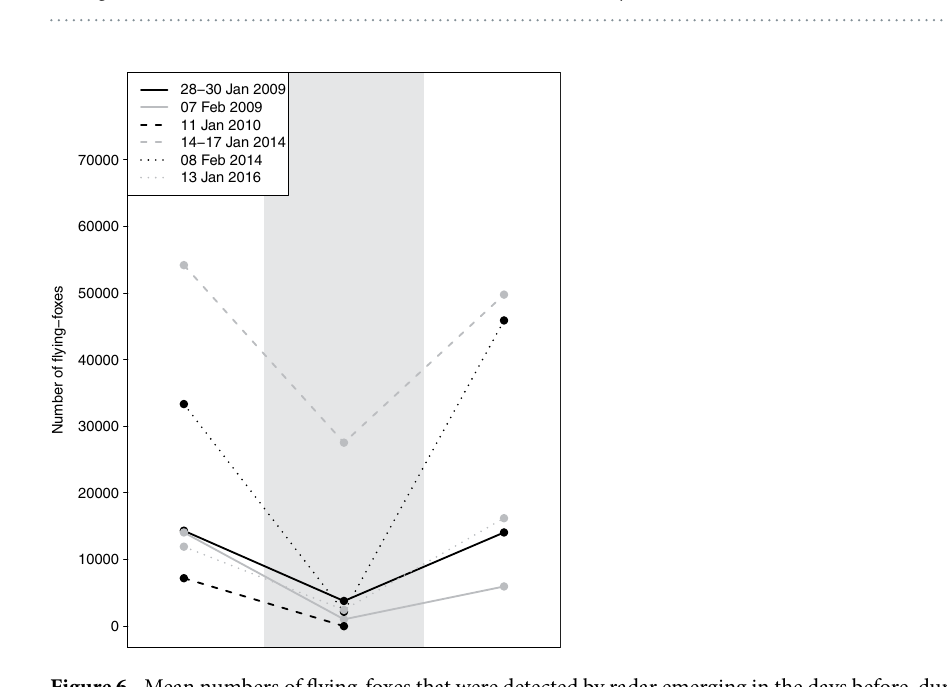
Figure 6. Mean numbers of flying-foxes that were detected by radar emerging in the days before, during, and after extreme heat events (T ≥ 42 °C 19 ). Means were taken from the week prior to an event, the ≥ 1 consecutive day(s) of the event, and from the week following the event. Mean emergences (dots) are linked by individually identifiable lines for each extreme heat event. The grey polygon indicates the period of extreme heat. The date of each event is indicated by the